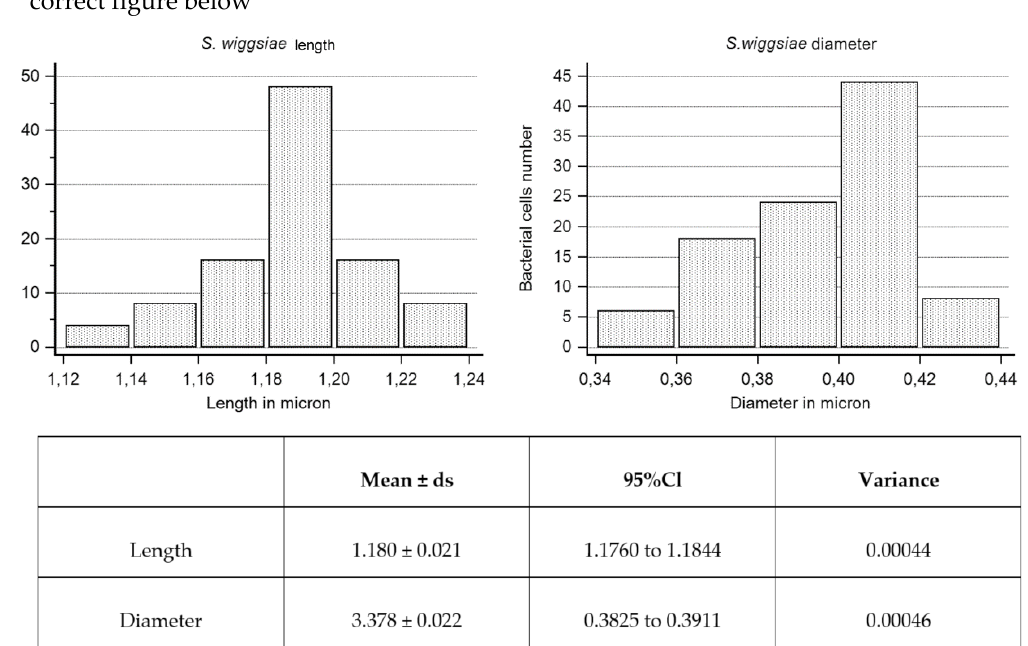
Figure 6. S. wiggsiae length and diameter values and their statistical analysis.